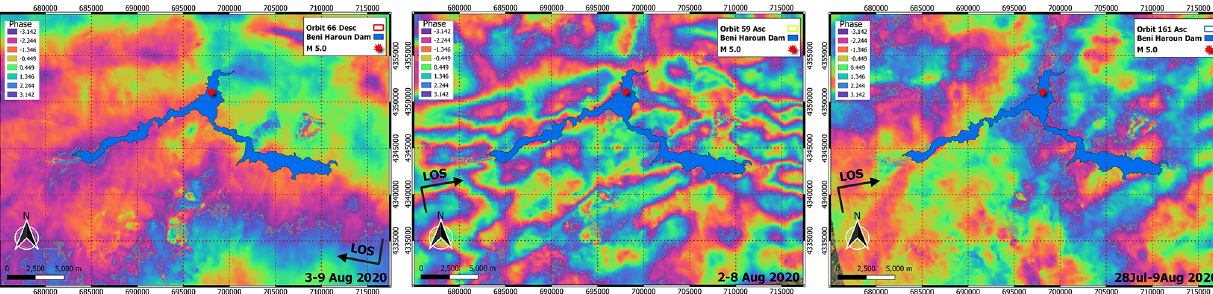
Figure 5. Wrapped interferograms from Sentinel-1 for IFG-3 + IFG-4, IFG-17, and IFG-22. The red star is the epicenter location (USGS,2021a).